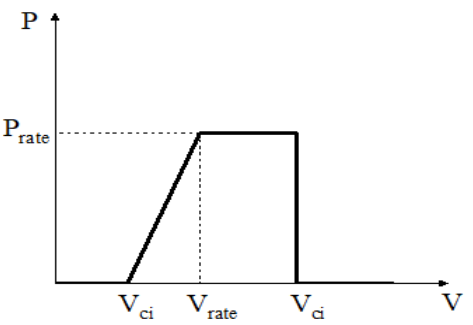
Figure 1. The relationship between wind speed and power generation.